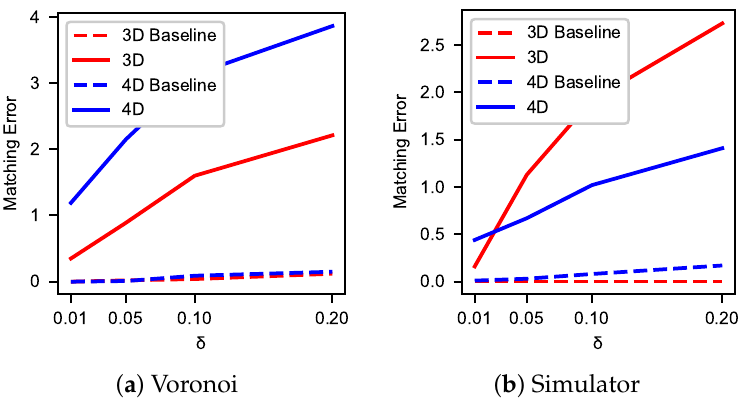
Figure 2. Average number of matching errors made by the algorithm as function of line search precision (see text). We show results on the 3D and 4D problems for our algorithm and the idealized baseline. ( a ): Voronoi region problem. ( b ): Problems drawn from the quantum device simulator.